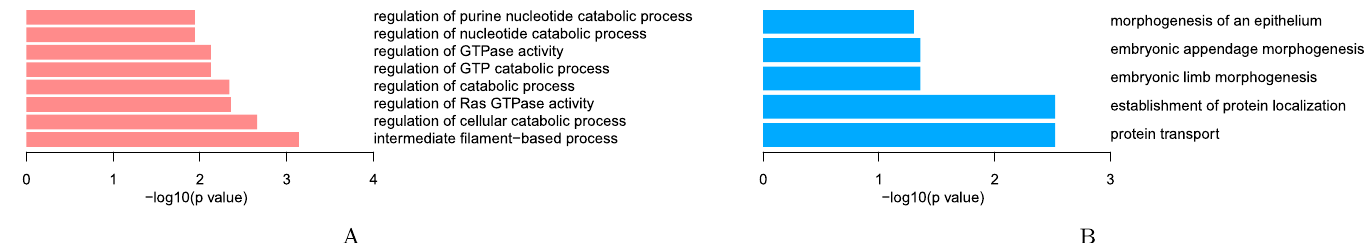
Fig 4. Network ontology of corresponding genes for 50 alternative splicing events. (A) Corresponding ascending genes. (B) The corresponding descending genes.